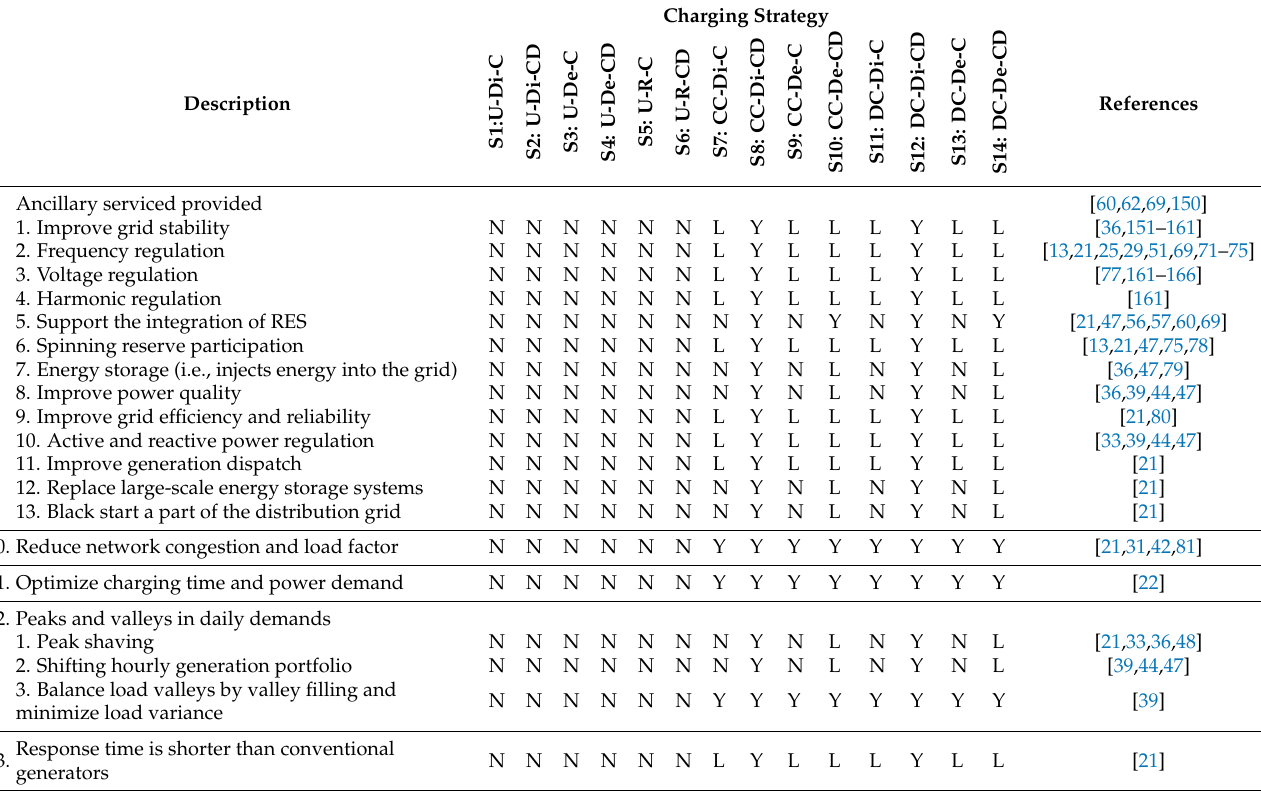
Table 6. Ancillary Services and Peak Demand Aspects Comparison for Different EV Charging Strategies.